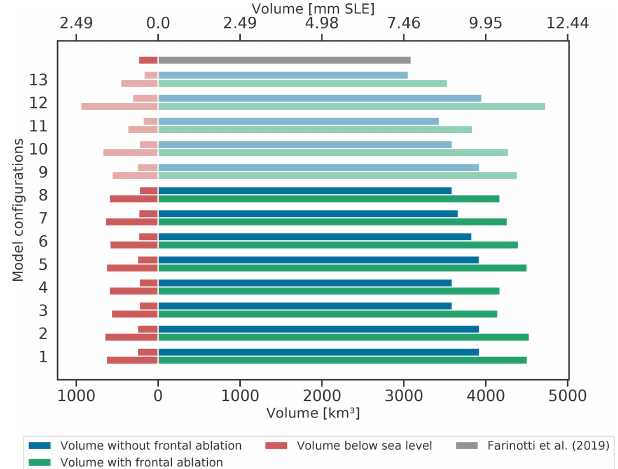
Figure 8. Total volume of Alaskan marine-terminating glaciers be- fore (blue) and after (green) accounting for frontal ablation and the total volume below sea level (red) before and after accounting for frontal ablation. The lightly shaded colour bars represent configura- tions obtained from finding the intercepts between OGGM frontal ablation estimates and the lower and upper error provided by McN- abb et al. (2015). The grey bar represents the consensus estimate for these glaciers obtained by Farinotti et al. (2019). The descriptions for each configuration can be found in Table